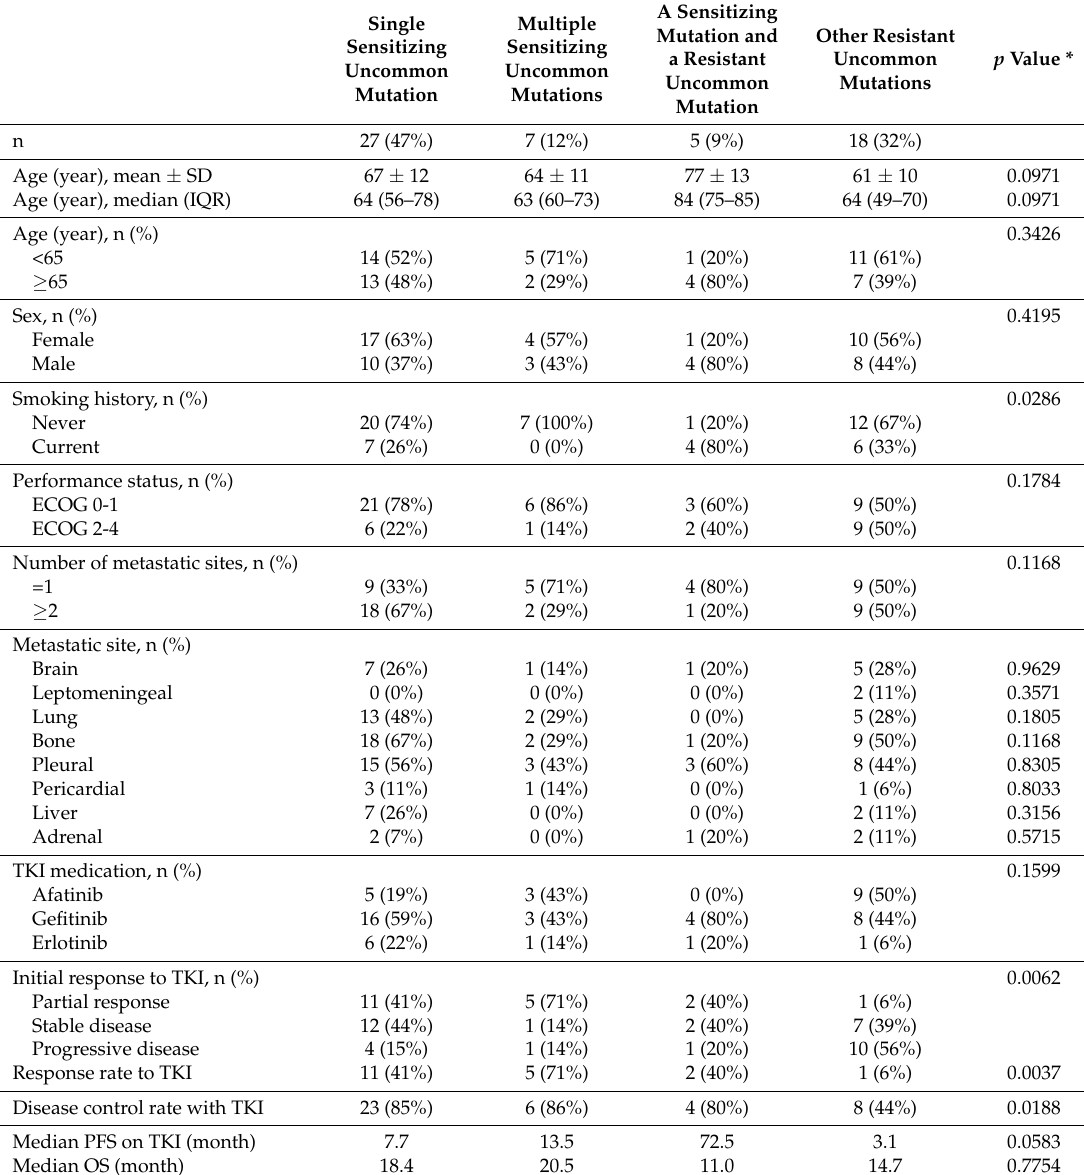
Table 3. Characteristics of the patients with stage IV lung cancer harboring uncommon mutation receiving a first-line tyrosine kinase inhibitor (TKI), classified by the drug susceptibility of EGFR mutation † . Single